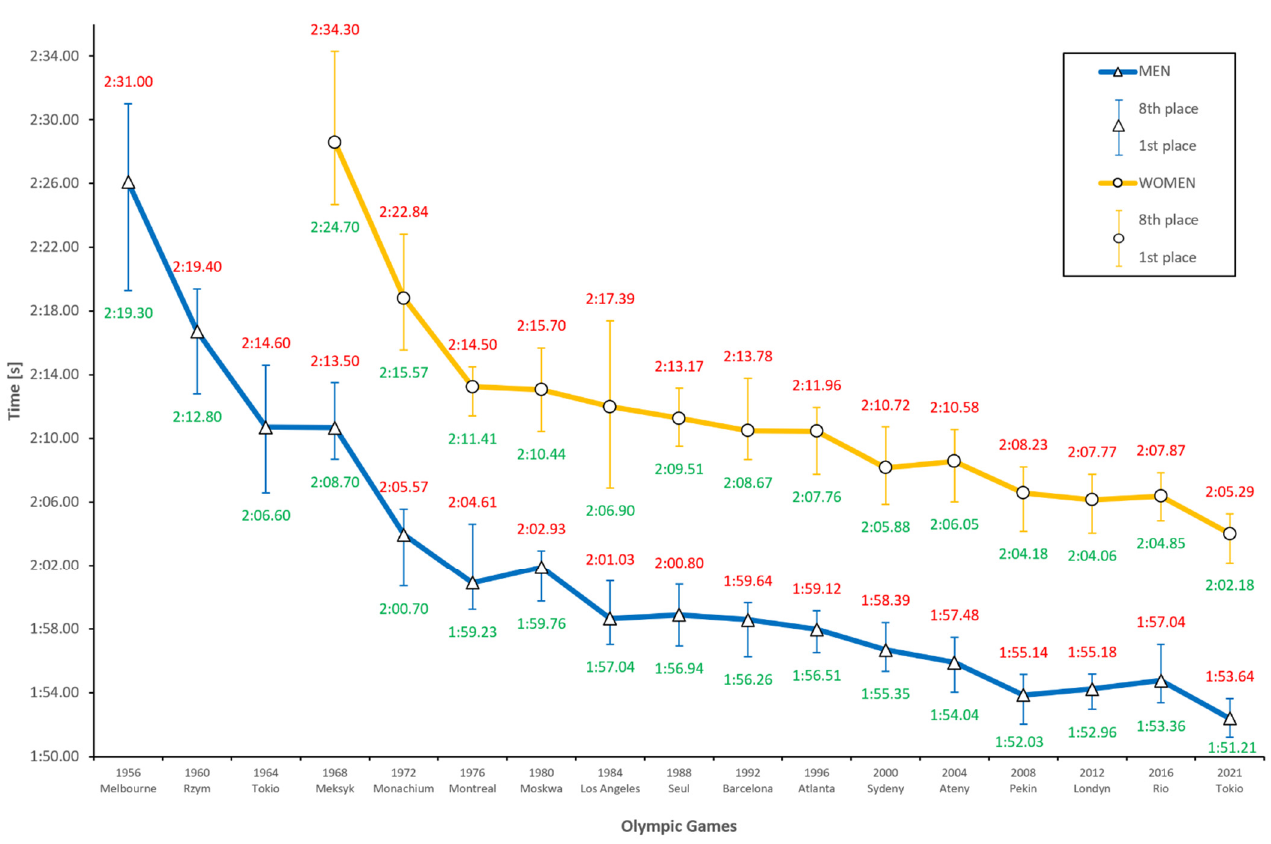
Figure 4. Men’s and women’s 200 m butterfly results during the last 16 Olympic Games and prediction for Tokyo 2021. Table 2. Results and differences for the winners in the Rio Olympics in 2016 and the results predicted for the Olympics in